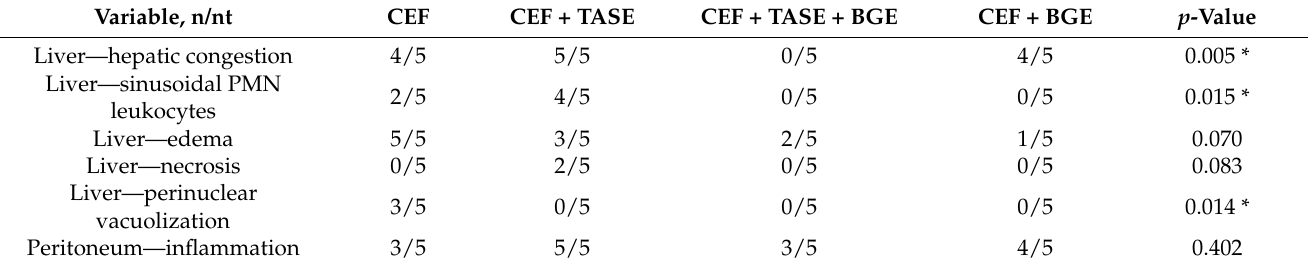
Table 4. Histopathological analysis and organ evaluation in relation to inflammation, congestion, and vacuolization. * p ≤